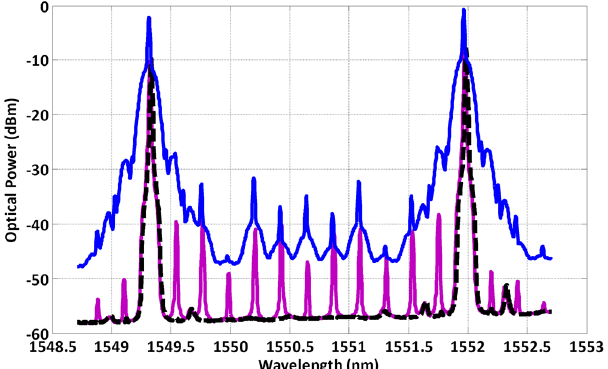
Figure 5. Optical spectrum of the hybrid InP/Polymer dual DBR Photonic Integrated Circuit with 330 GHz spacing between wavelengths under different conditions: (dashed black) free-running, (pink) with optical injection from the external OFCG, and (blue) after the MZM, with a pseudo-random bit data stream at 18 Gbit/s.